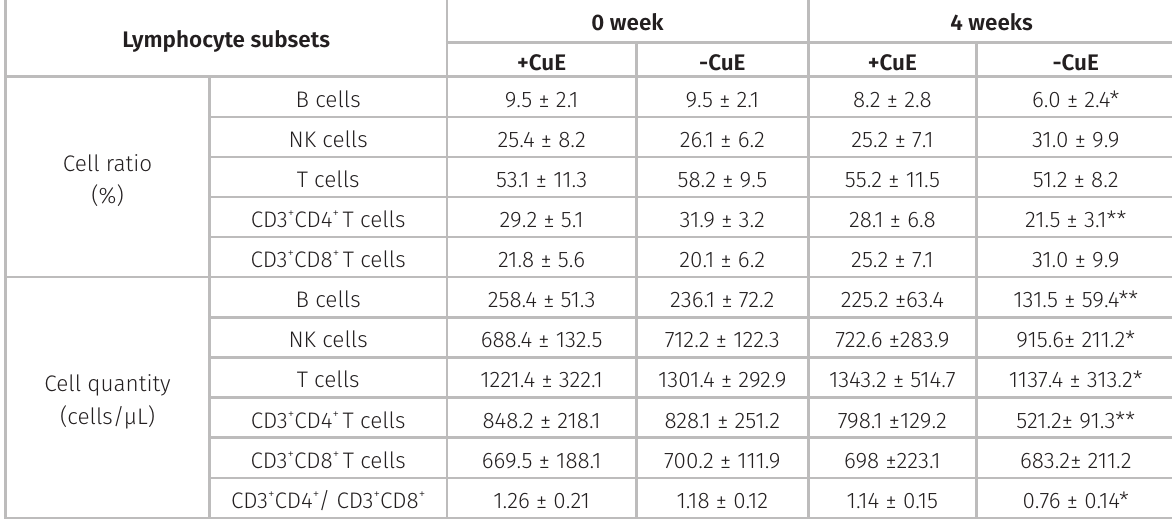
Table I. Effects of 4-week altitude training on the lymphocyte subsets of basketball